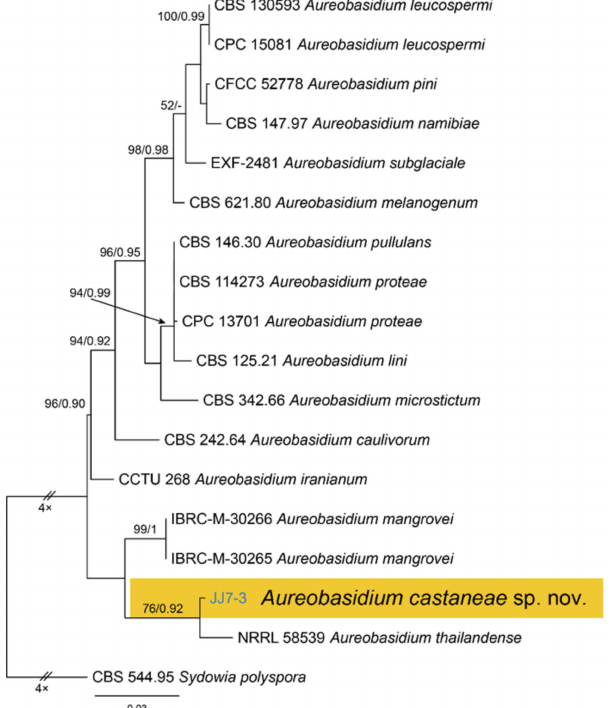
Figure 5. Phylogram generated from RAxML analysis based on combined ITS and LSU sequence data of Aureobasidium isolates. The tree was rooted to Sydowia polyspora (CBS 544.95). The scale bar indicates 0.03 nucleotide changes per site. Isolate from this study is marked in blue, and the identified species is marked in